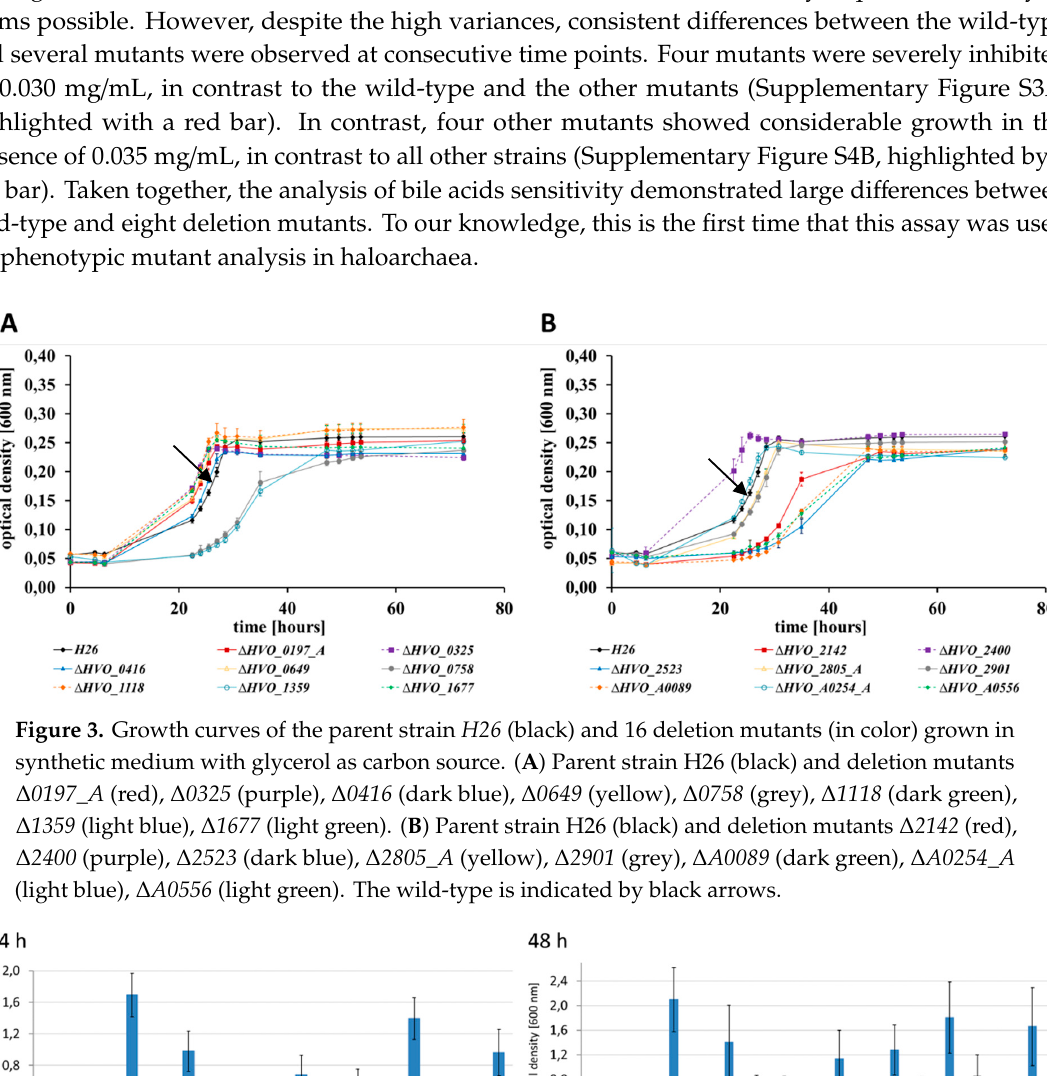
Figure 5. Comparison of the swarming velocity of the parent strain H26 (black) and its 16 deletion mutants after 24 h and 44 h incubation. Average values of three biological replicates and their standard deviations are shown. At both time points, the swarming diameters of the mutants were normalized to that of the parent strain H26 (= 100%). The wild-type had a swarming diameter of 5 mm after 24 h and 23 mm after 48 h. The cultures were injected into the semi-solid agar using a tip with 1 mm diameter. Colonies with no observable swarming with a colony diameter of less than 2 mm after 44 h were regarded to have a null phenotype. The mutants with a null phenotype are indicated by red asterisks. 4. Discussion Until now, only very few archaeal µ-proteins of less than 70 aa have an annotated function and have been experimentally characterized. Many of these are small subunits of large complexes, e.g., eight subunits of the ribosome belong to this group (Rps14/17e and Rpl20e/24e/29/37e/39e/40e), as